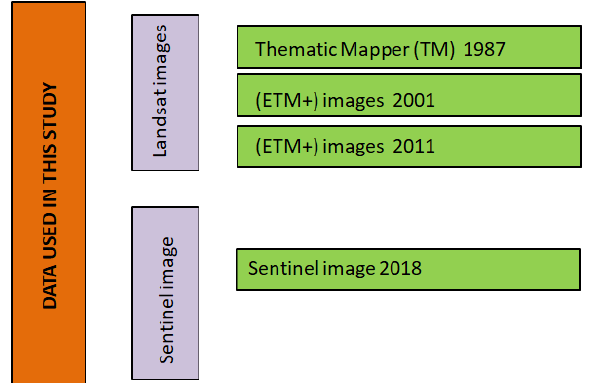
Fig.3: Flow charts of the data for land use/land cover and change detection.